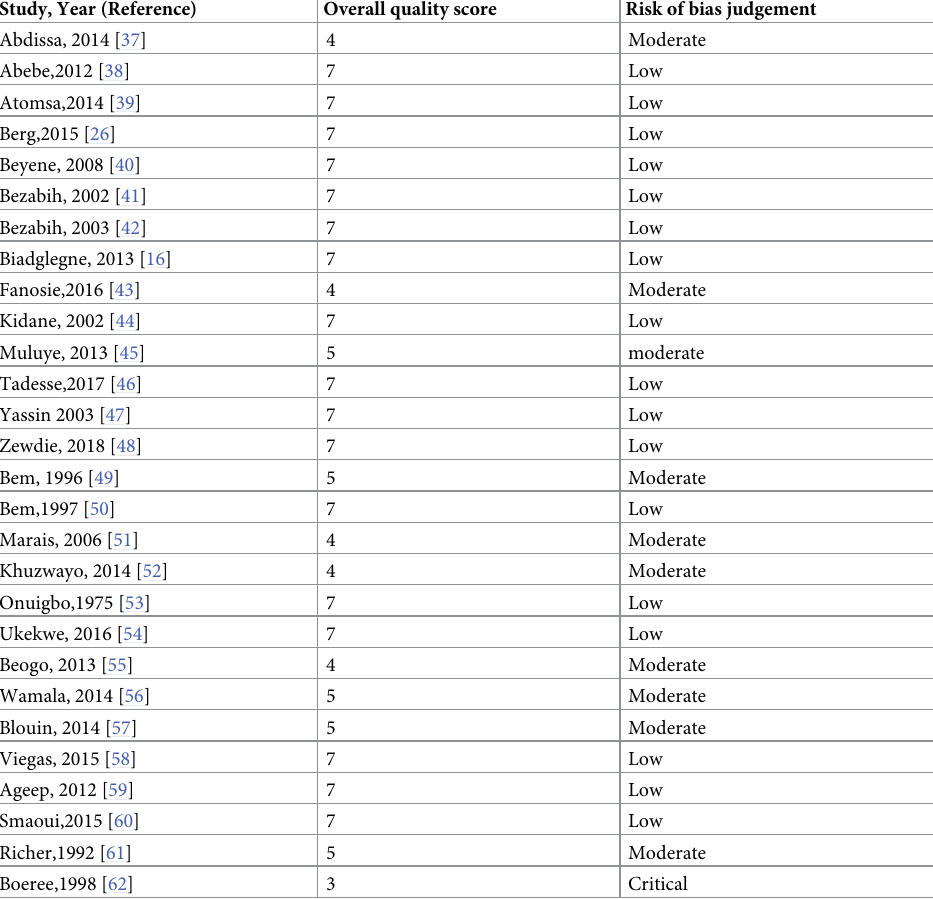
Table 2. Robbins-I risk of bias summary for the included articles, Africa,